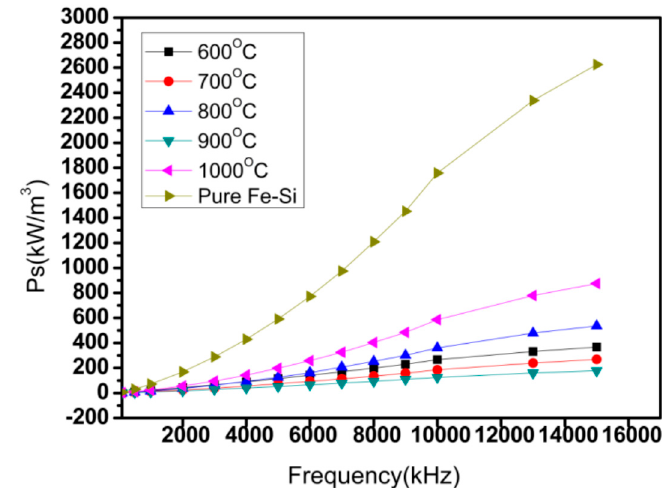
Figure 13. Total core loss as a function of frequency for Fe-Si composite and Fe-Si/MnZn(Fe 2 O 4 ) 2 composite with different sintering temperatures measured at maximum induction of 50 mT in the frequency range from 1 kHz to 15 kHz.